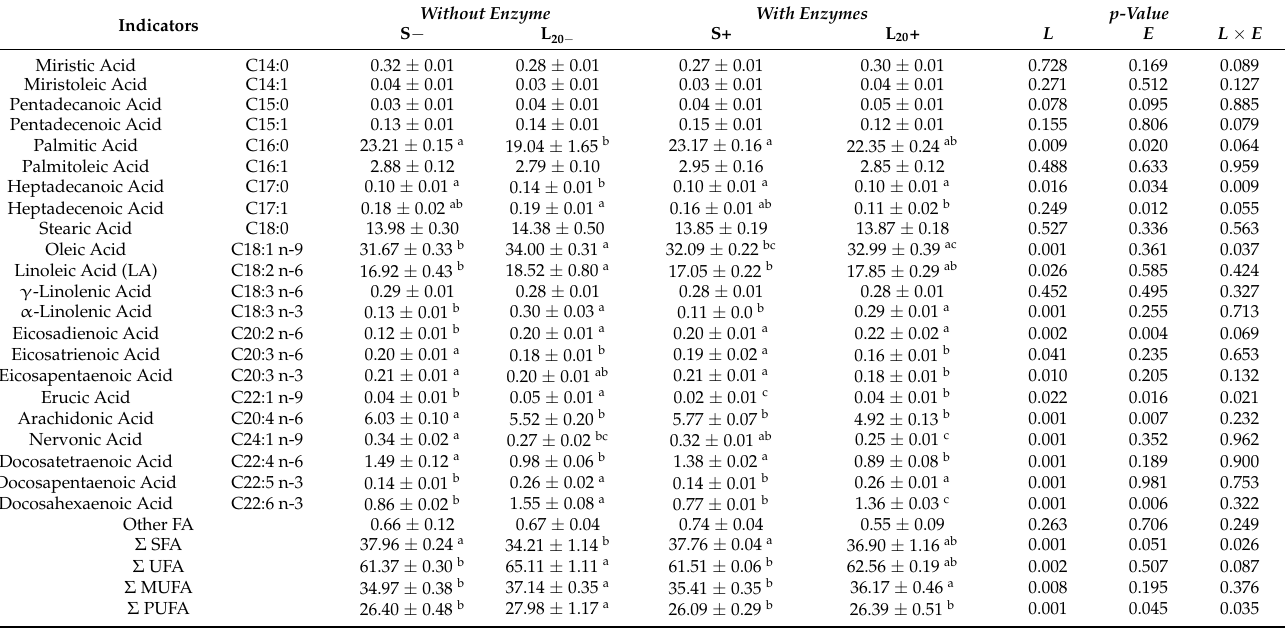
Table 8. Influence of enzymes addition in lupine-based diets on FAs’ profile of fats in the yolk of quail eggs (% of FAME).